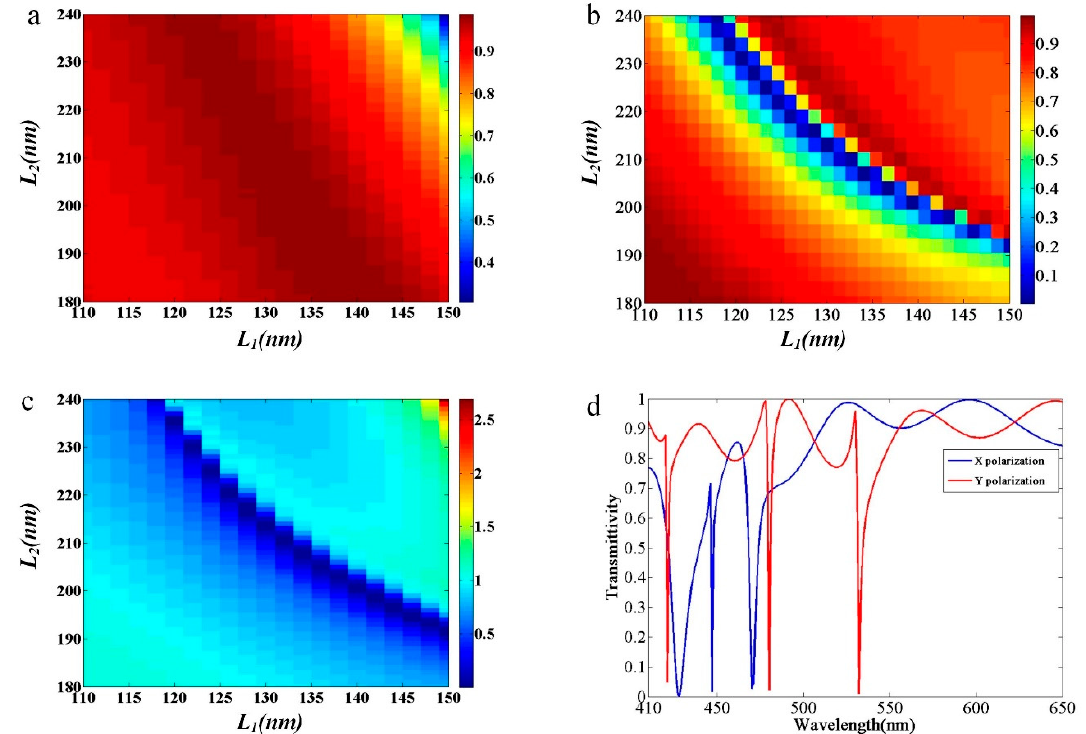
Figure 2. ( a ) Calculated transmittivity for the y -polarized incidence at a wavelength of 532 nm. ( b ) Calculated transmittivity for the x -polarized incidence. ( c ) Calculated R t distribution. ( d ) Transmittivity spectrum for x -polarized (blue line) and y -polarized (red line) incidence with lengths L x and L y respectively equal to 120 and 235 nm.